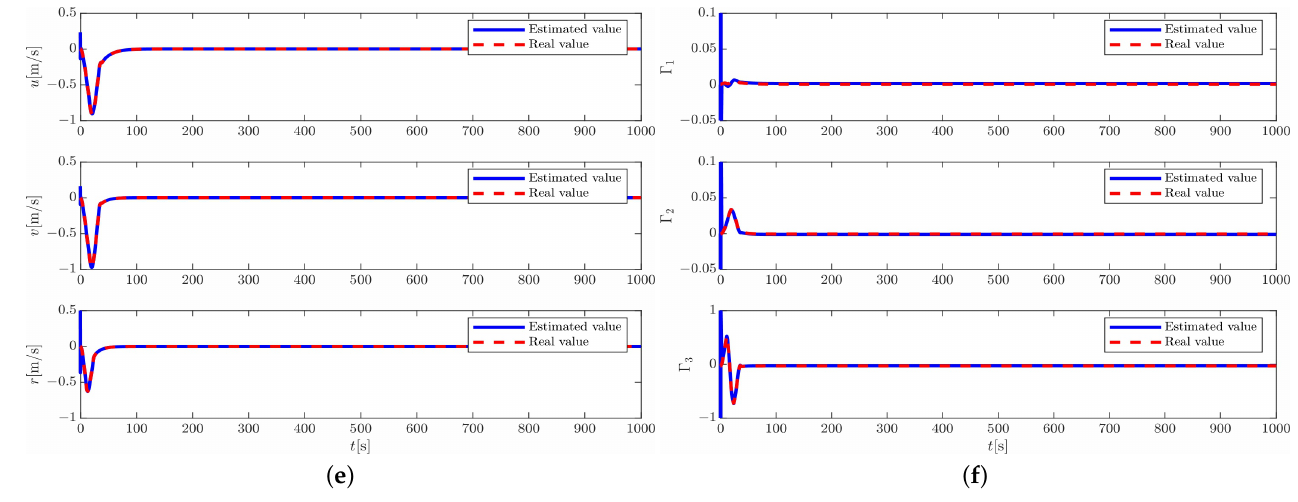
Figure 5. Comparison of simulation results for output feedback vs state feedback in MSS toolbox: ( a ) ship horizontal motion trajectory; ( b ) ship position and heading; ( c ) ship speed; ( d ) actual thrust generated by ship thrusters; ( e ) estimated and true values of speed; ( f ) estimated and true values of set total